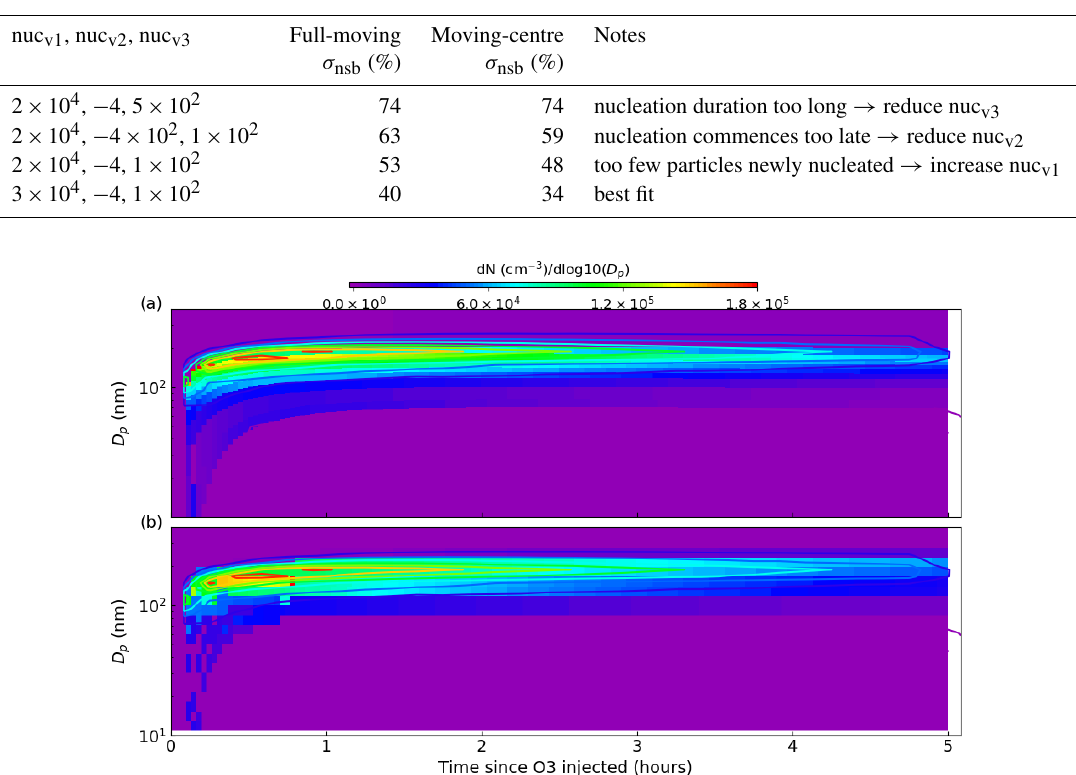
Figure 11. Comparing number size distributions from best-fit (defined in Table 1) PyCHAM simulations using the full-moving (a) and moving-centre (b) size structures against observations from a dark limonene oxidation chamber experiment with nucleation. Experiment conditions and simulation setup are given in the main text. Observations are presented as contour lines, whilst model results are filled contours, with both using the colour axis given at the top of the plot. The degree of agreement here is indicated by the difference in these contours at any one